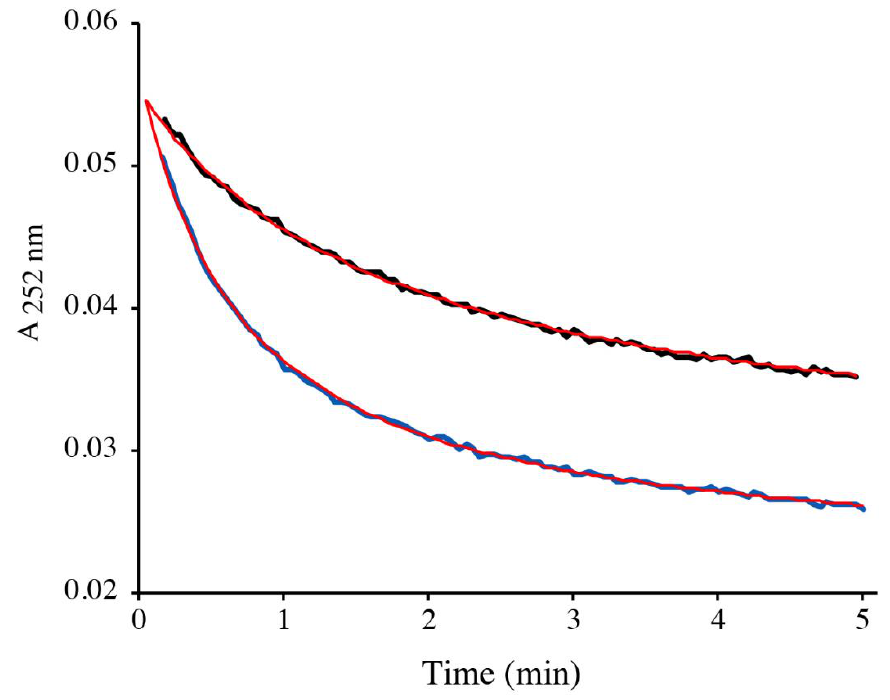
Figure 2. Reduction of DMDSe by GSH. 100 µ M DMDSe was mixed with 1 mM GSH (containing 15 µ M GSSG) in the absence (black trace) or presence (blue trace) of 50 µ M added GSSG in 100 mM potassium phosphate, pH 7.4. The absorbance at 252 nm was recorded as a function of time starting 7 to 8 s after mixing. The absorbance of a solution of 100 µM DMDSe alone, measured with a control sample, was 0.016. The experimental data were fitted to the kinetic model described in Supplementary Materials (red lines). Table 1. Equilibrium and rate constants deduced from spectrophotometric experiments with mixtures of DMDSe, GSH, and